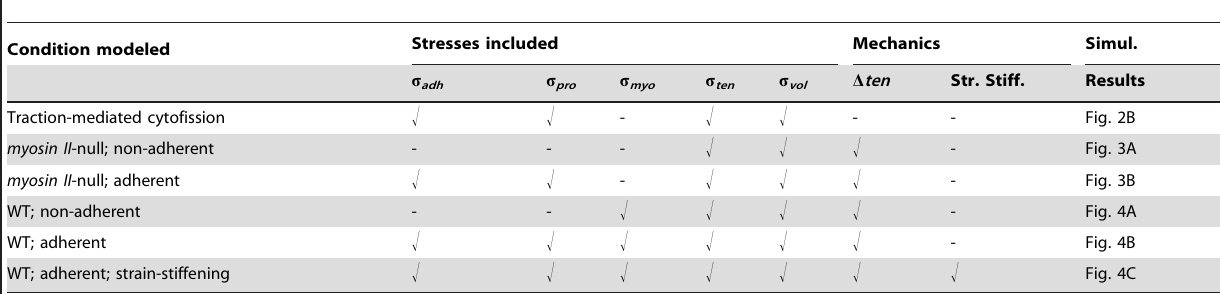
Table 1. Simulations